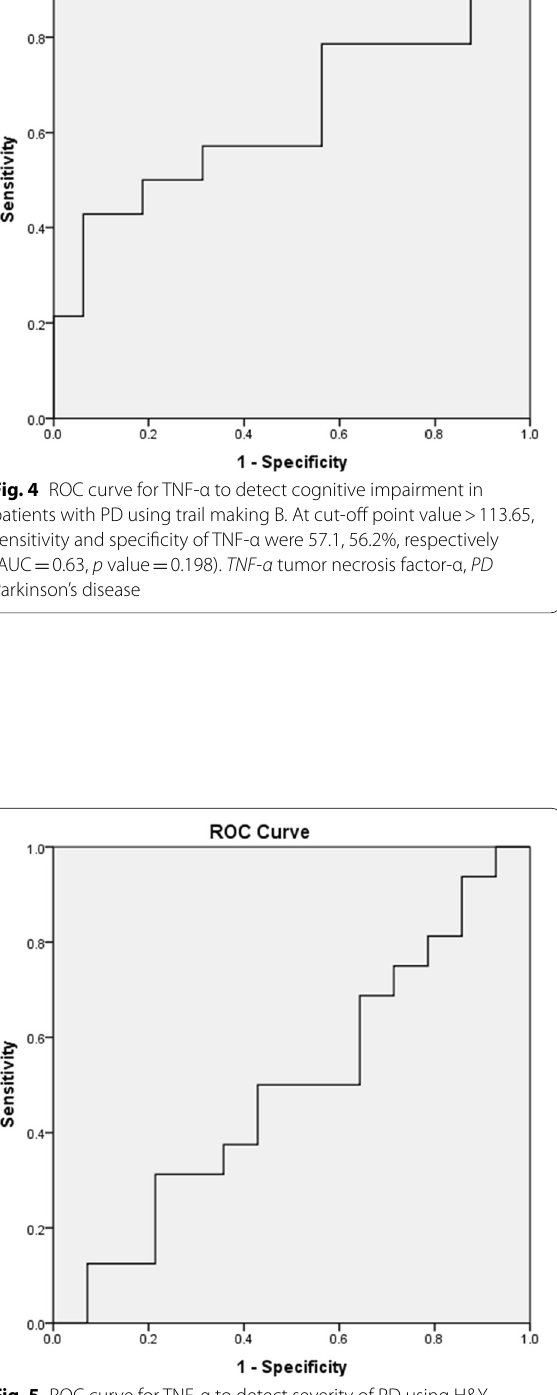
Fig. 5 ROC curve for TNF‑α to detect severity of PD using H&Y staging. At cut‑off point value > 113.65, sensitivity and specificity of TNF‑α were 50% (AUC 0.49, p value 0.69). TNF-α tumor necrosis = = factor‑α, PD Parkinson’s disease, H&Y Hoehn and